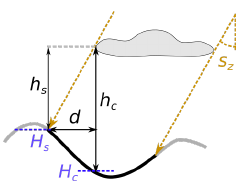
Figure 17. Principle of the measurement of cloud- and shadow-borders